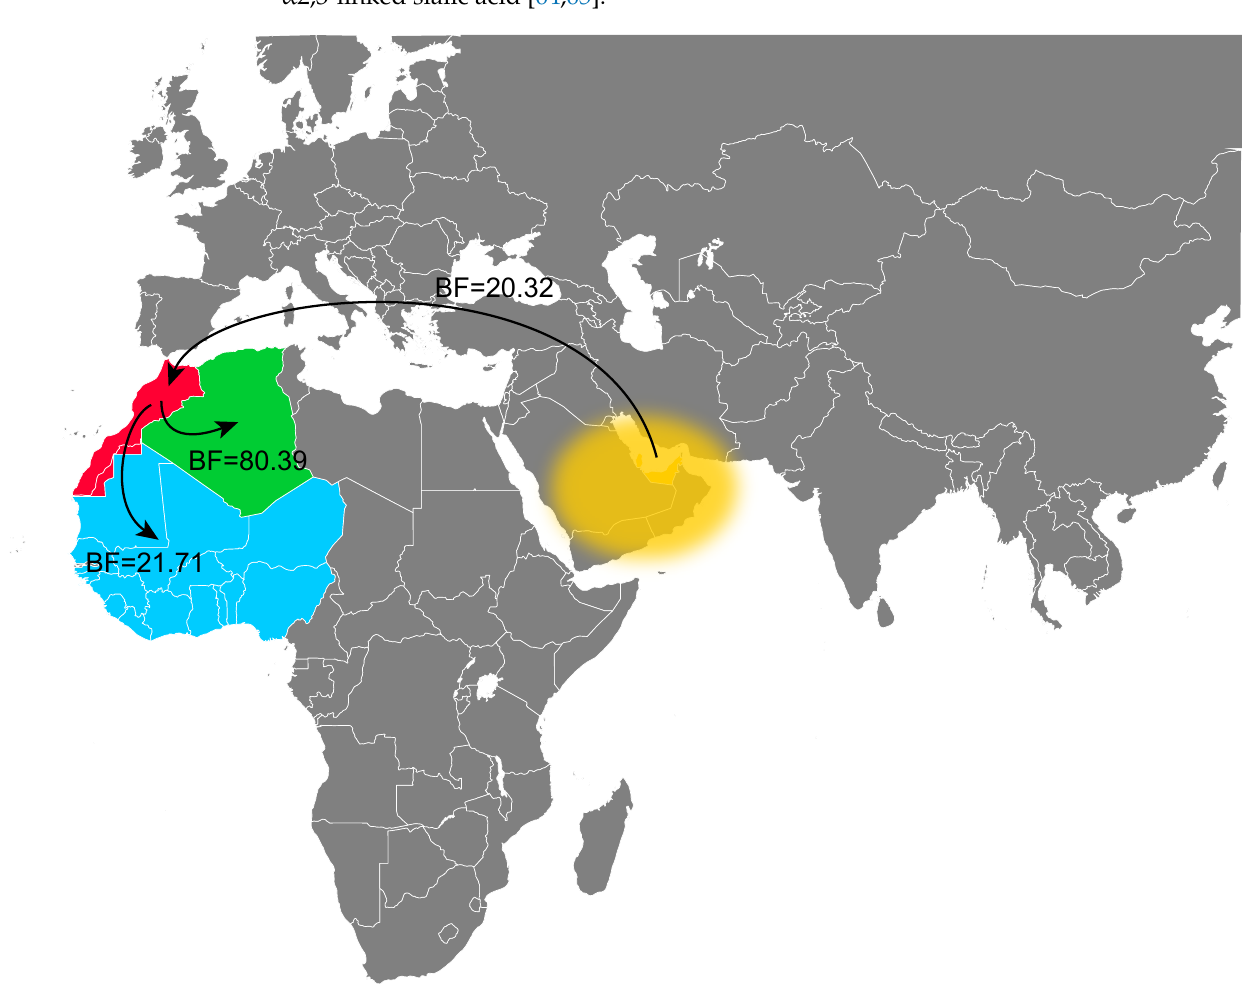
Figure 4. Spatiotemporal dynamics describing the geographic origins of Moroccan H9N2 viruses and the virus spread from Morocco to other African countries. Supported transitions are indicated by continuous lines (BF >